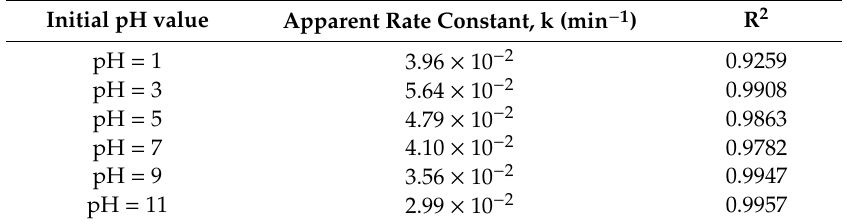
Figure 5. E ff ect of initial solution pH on degradation e ffi ciency of NOR ( a ) and the corresponding Figure 5. Effect of initial solution pH on degradation efficiency of NOR ( a ) and the corresponding pseudo first-order kinetics ( b ). Experimental conditions: [NOR] = 10 mg / L, [PS] = 2 mM, and electrolyte: pseudo first-order kinetics ( b ). Experimental conditions: [NOR] = 10 mg/L, [PS] = 2 mM, and 0.1 M Na 2 SO 4 . electrolyte: 0.1 M Na 2 SO 4 . Table 2. The kinetic parameters of NOR degradation at di ff erent initial pH